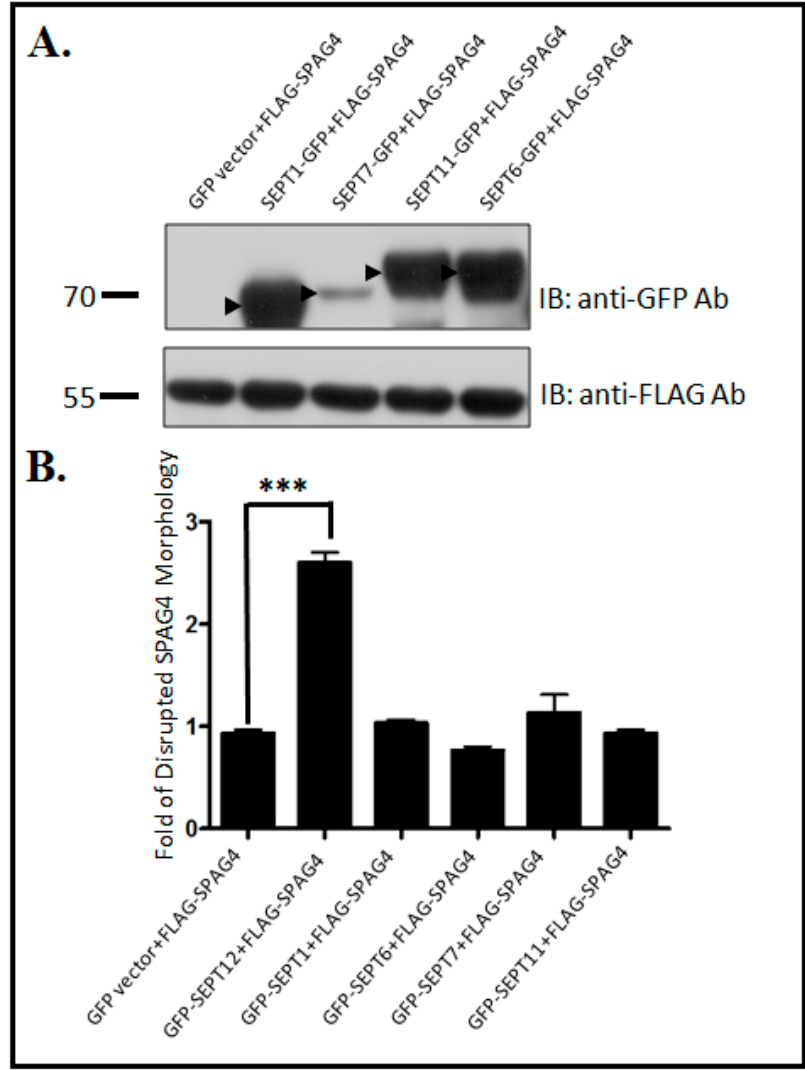
Figure 3. Effects of SEPT1/6/7/11 on SPAG4 localization around the NE in the NT2/D1 male germ cell line ( A ) Western blot analysis of NT2/D1 cells transfected with the pEGFP-vector, pEGFP-SEPT1, pEGFP-SEPT7, pEGFP-SEPT11, or pEGFP-SEPT6 with pFLAG-SPAG4 using the anti-GFP antibody (anti-GFP Ab) and anti-FLAG antibody (anti-FLAG Ab). ( B ) Fold changes in disrupted SPAG4 localization in transfected cells with the pEGFP-vector, pEGFP-SEPT12, pEGFP-SEPT1, pEGFP-SEPT6, pEGFP-SEPT7, or pEGFP-SEPT11 with pFLAG-SPAG4. The height of the boxes represents the mean of values obtained from three independent experiments. At least 100 transfected cells were counted in each experiment (*** p < 0.001, Student t test).